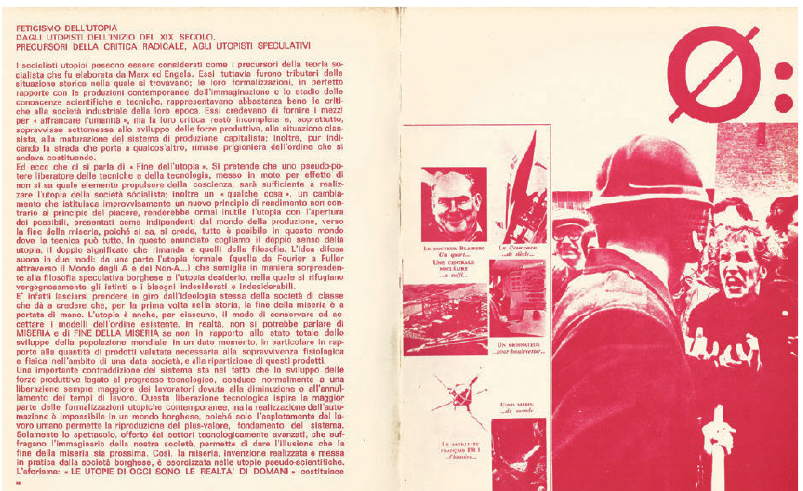
on “Utopia e/o rivoluzione” (July